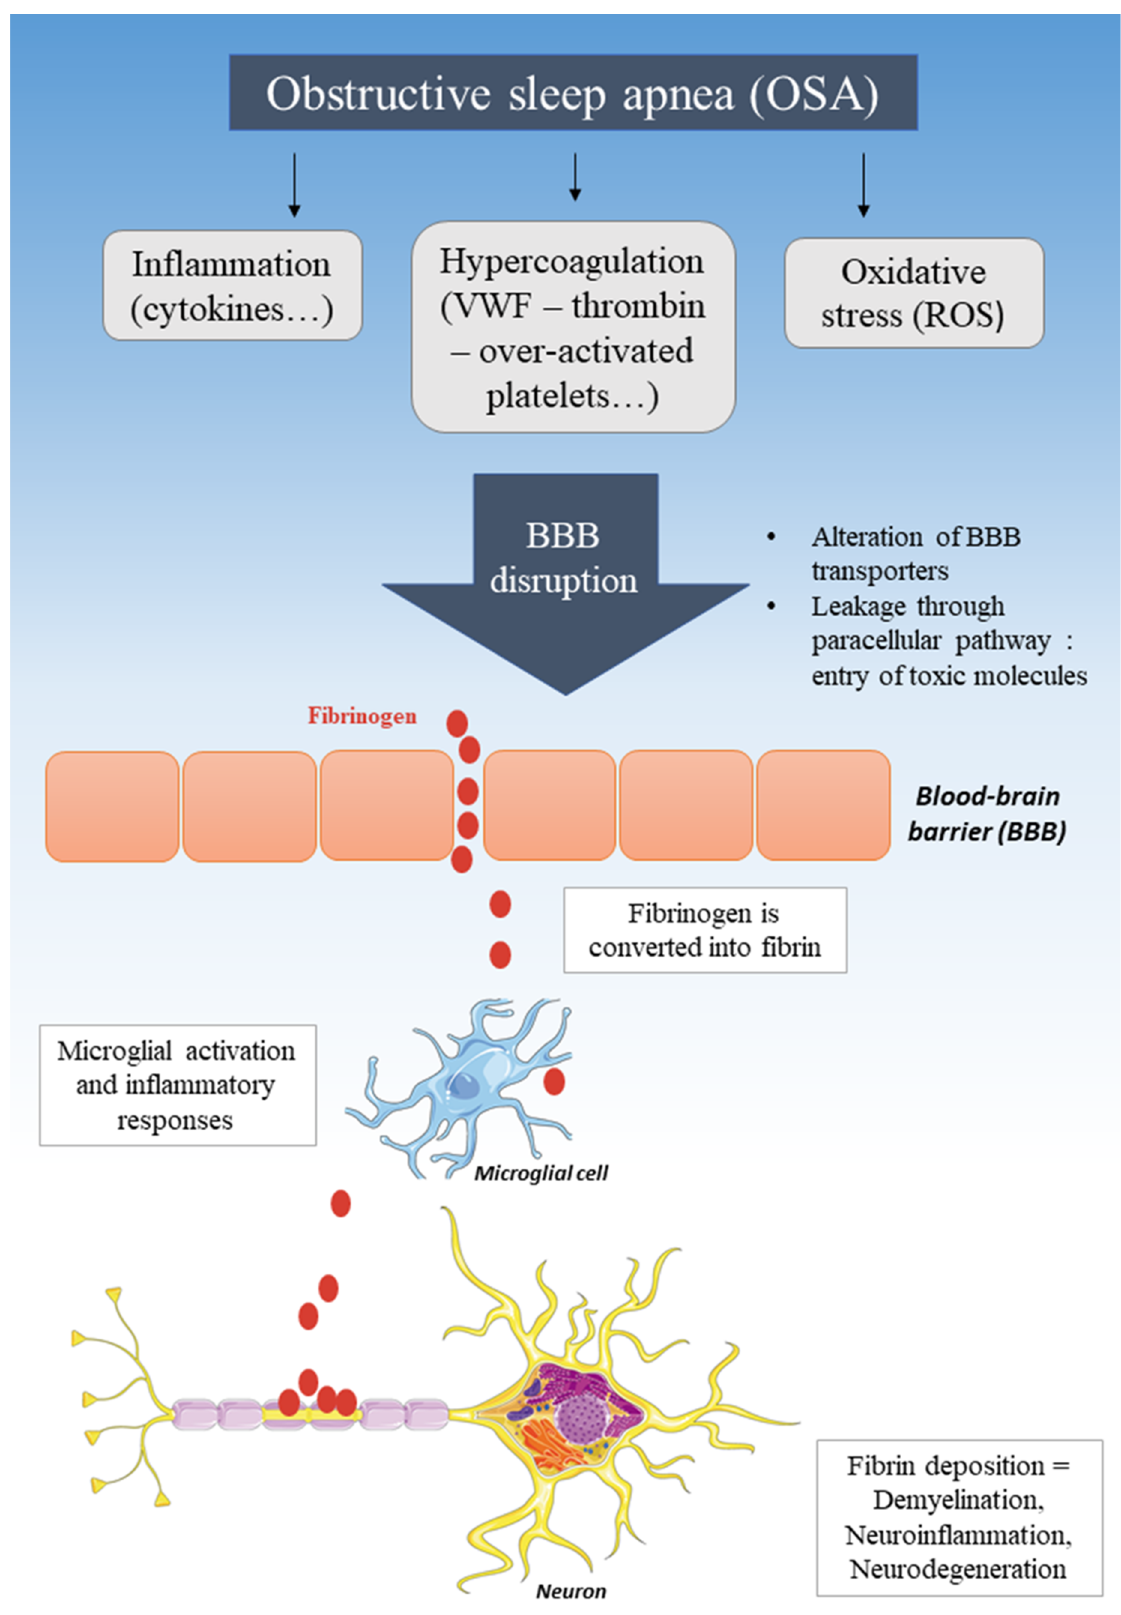
Figure 2. Pathogenic mechanism of obstructive sleep apnea (OSA) leading to blood–brain barrier (BBB) disruption and neurodegeneration. ROS: reactive oxygen species, VWF: von Willebrand factor.